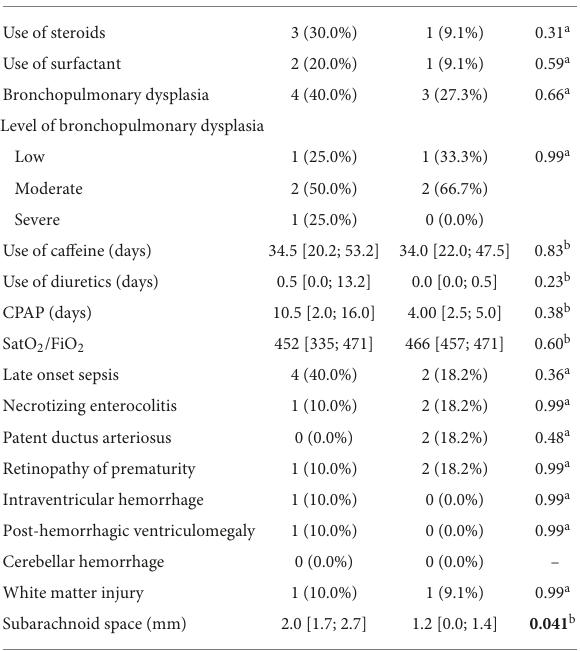
TABLE 3 Neonatal clinical outcomes according to the ARA:DHA group